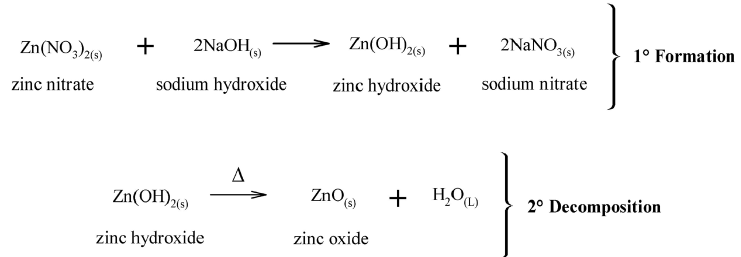
Figure 3. Steps stoichiometric ZnO formation by polyol method.